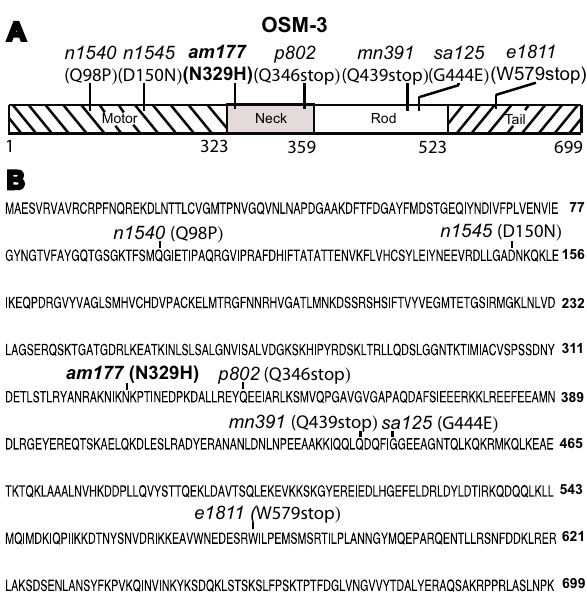
Figure 4. am177 is a missense mutation of osm-3 . (A) A schematic of the OSM-3 protein showing amino acid numbers (below) and four functional regions: the motor (left diagonal lines), neck (shaded), rod (open) and tail (right diagonal lines) [47]. The position of am177 and six previously characterized mutations are shown above with the mutation name and molecular change [47]. (B) The predicted amino acid sequence of OSM-3 (M02B7.1B). The am177 mutation changes codon 329 from A AC (N) to C AC (H), affecting the neck region of the